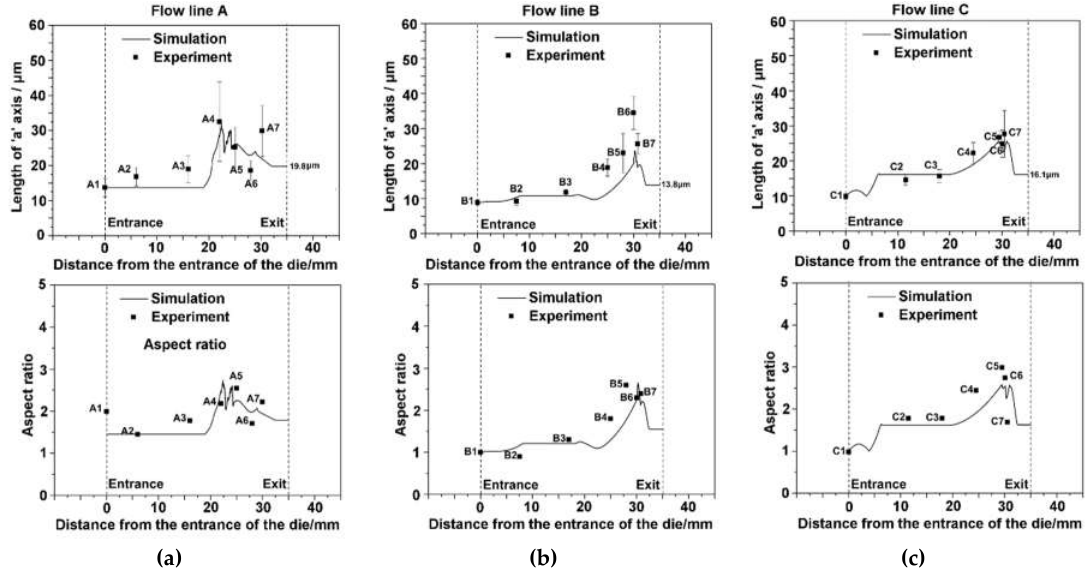
Figure 13. Experiment and simulation of the grain morphology in terms of grain size and aspect ratio associated with the ( a ) flow line A; ( b ) flow line B; and ( c ) flow line